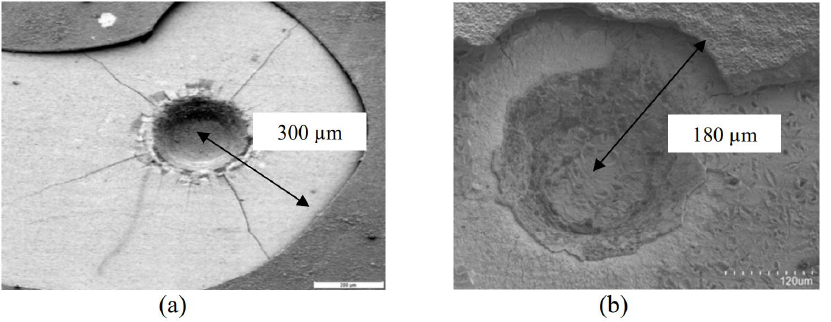
Figure 3. Effect of sandblasting with diamond powder on Cr-coated WC-Co substrate: ( a ) delamina- tion area without sandblasting and ( b ) the elamination area with sandblasting